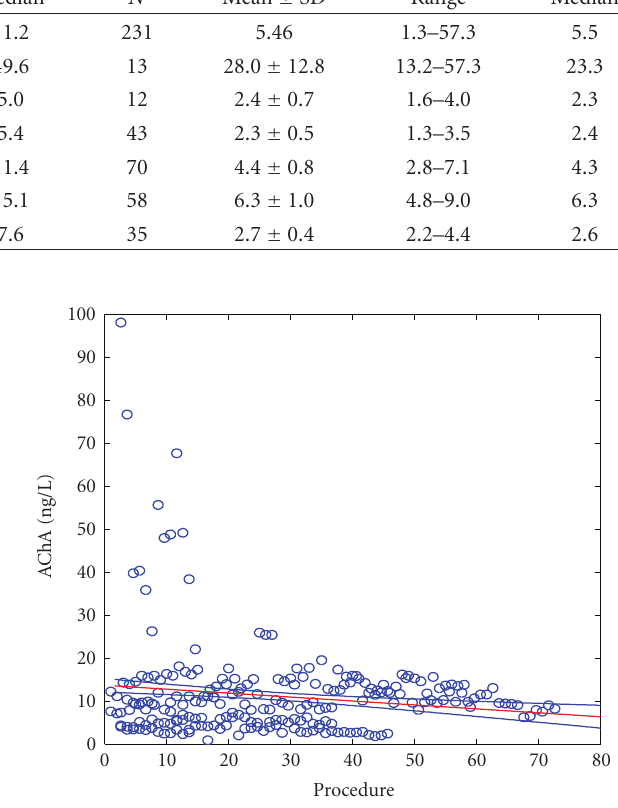
Figure 2: AChRA levels—all examinations. Y axis = AChRA level in ng/L; X axis: Procedure = numeral order of procedures from the start of